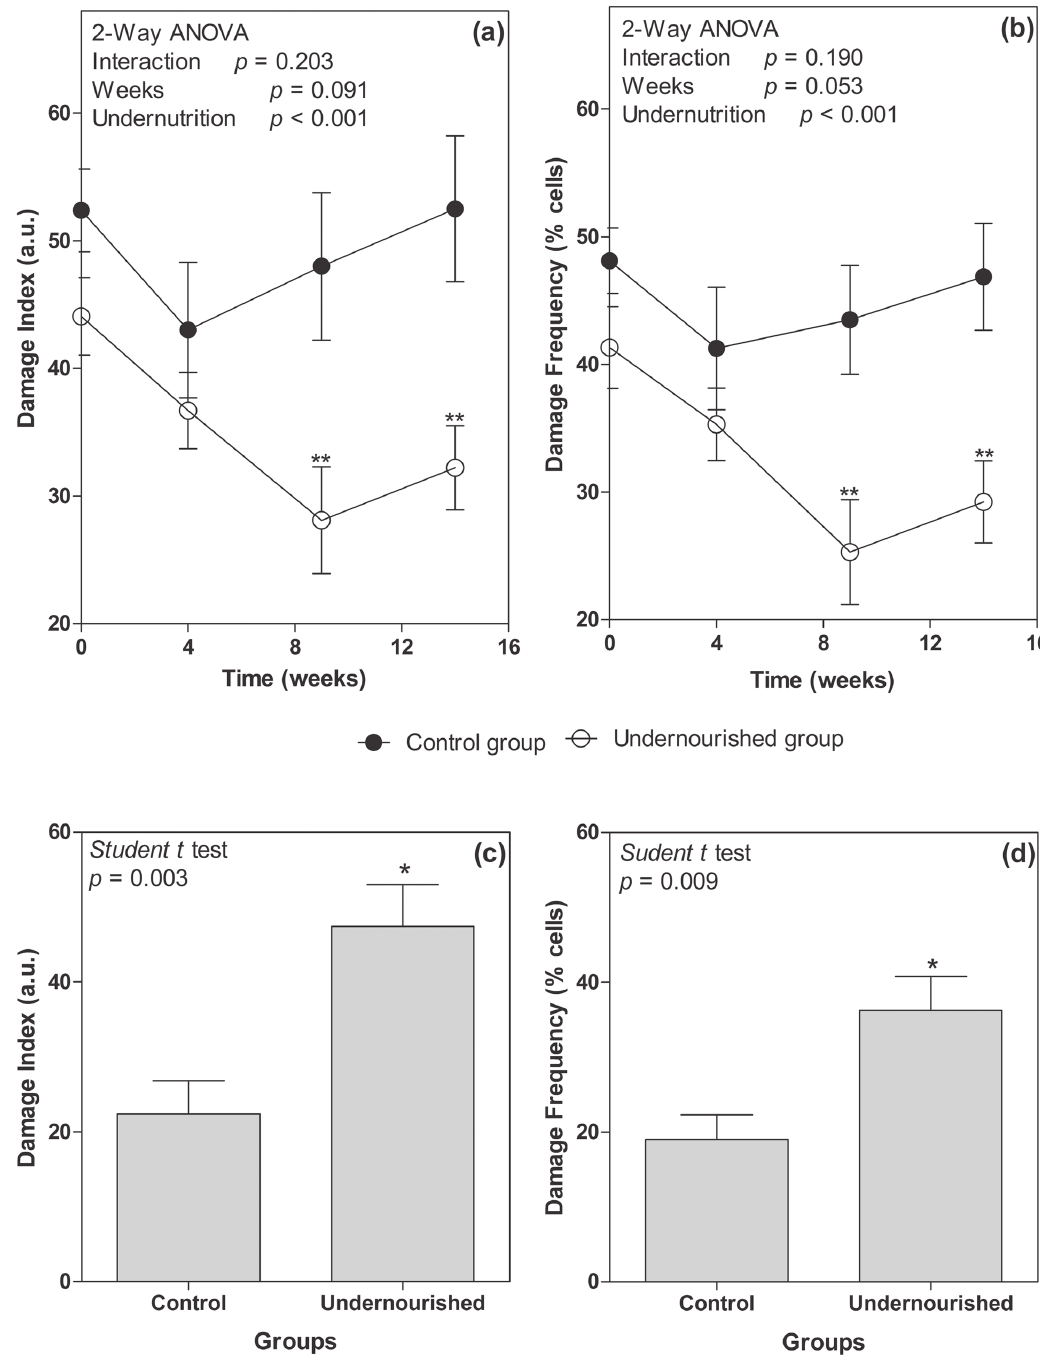
Figure 3 - Level of DNA damage index in the blood and hippocampus of rats submitted to caloric restriction for 14 weeks. The graphs ( a ) and ( b ) present the evolution of the DNA damage index in blood cells according to the damage index and damage frequency, respectively. The filled circles represent the control group and the unfilled circles the undernourished group. The statistical comparison was performed using the 2-way ANOVA followed by Sidak´s multiple comparison test. ** Statistical difference between groups in the same week ( p <0.01). ● Control group and ○ Undernourished group. The graphs ( c ) and ( d ) present the DNA damage level in hippocampus cells at the end of treatment, represented by the damage index and frequency, respectively p : level of significance according to the Student t test. a.u.: arbitrary unit. In the bars, significate difference is highlighted by